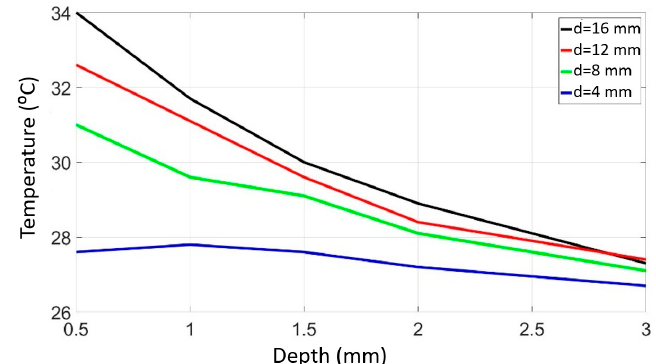
Figure 6. Effect of depth and size of the defect on the temperature distribution in a sample heated up by a halogen lamp for 75 s.